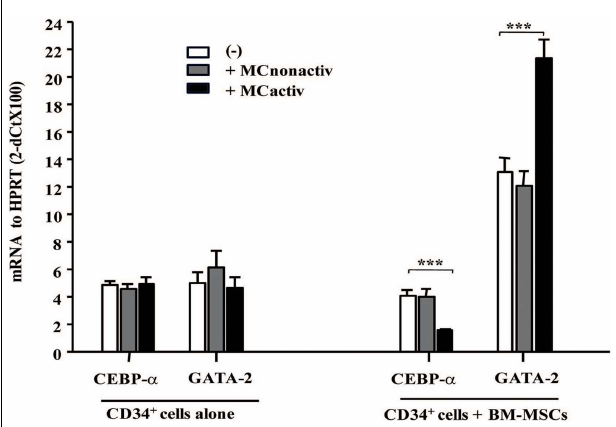
FIGURE 5 | Bone marrow-derived mesenchymal stromal cells preactivated with mast cells regulate allergy-related genes in CD34 + progenitors . BM-MSCs were exposed to non-activated or activated mast cells in aTranswell system and freshly isolated CD34 + cells were added to the cultures for 10h. Early genes for effector differentiation were analyzed in CD34 + cells following culture with BM-MSCs by real-time PCR. Mean ± SEM of four